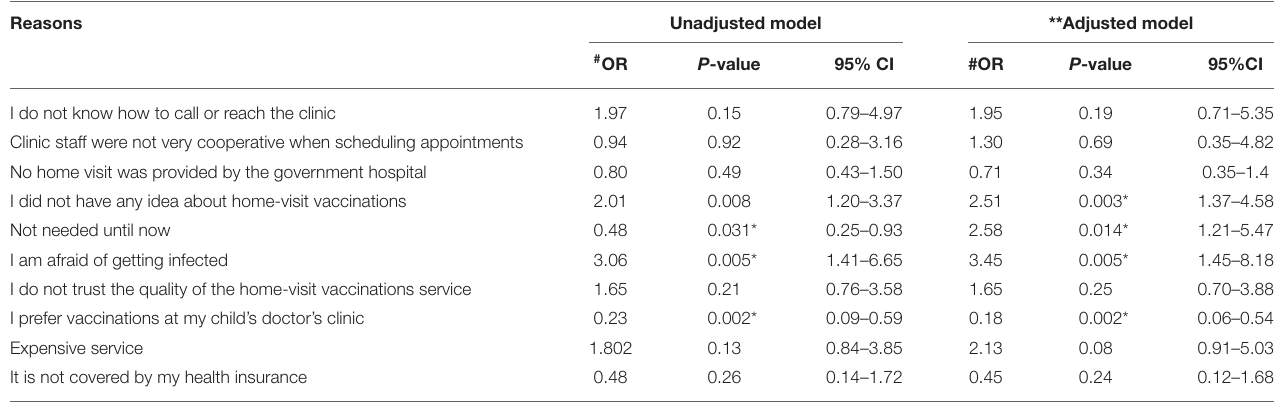
TABLE 5 | Reasons for not using the home-visit vaccinations and delaying vaccination: unadjusted and adjusted regression models.